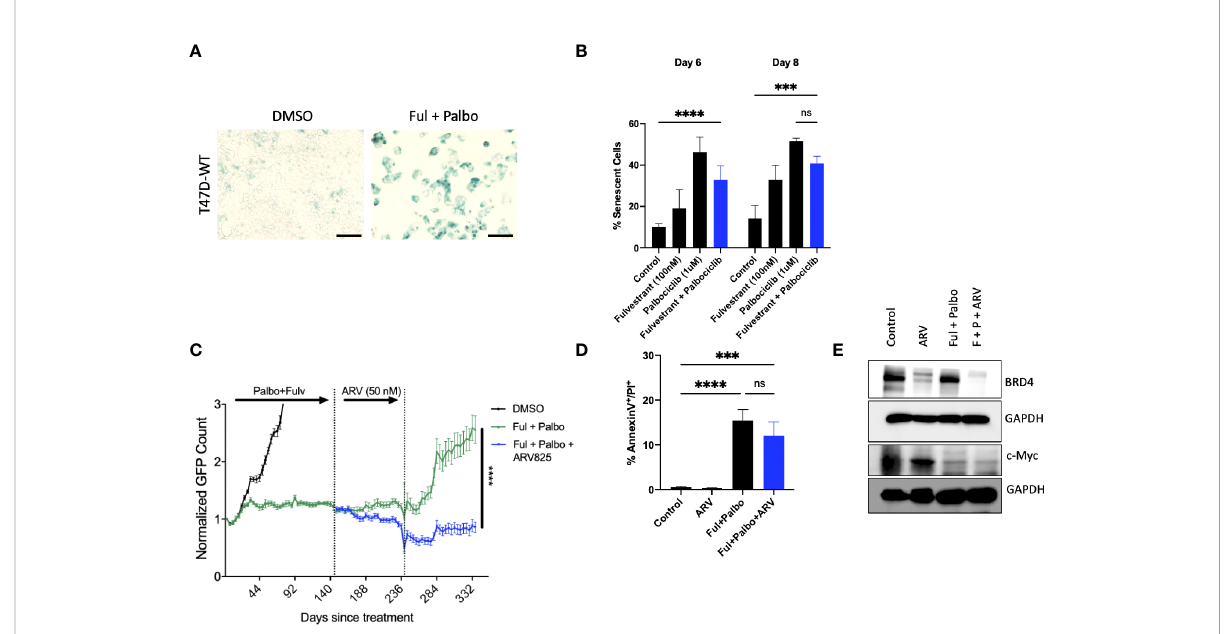
FIGURE 6 ARV prolongs growth arrest induced by Fulvestrant in combination with Palbociclib in p53 mutant T-47D cells. T47D-WT cells that were treated with palbociclib (1 µM) in combination with Fulvestrant (100 nM) for 6 days. (A) Cells were fi xed on Day 6, stained with x-gal staining solution, and imaged using bright fi eld microscope. All images were taken with the same magni fi cation. (B) Quanti fi cation of SA-Bgal using C12FDG at indicated timepoints. (C) Live cell viability was monitored via IncuCyte over a period of 14 days and normalized to GFP count. (D) Apoptosis was evaluated by fl ow cytometry using an APC Annexin V Apoptosis Detection Kit. (E) Western blotting for BRD4, c-Myc at day 4 of ARV treatment. Mean and SD were determined based on triplicates from 3 independent experiments. ***P ≤ 0.001, ****P ≤ 0.0001, ns (not signi fi cant) indicate statistical signi fi cance of each condition compared to control as determined using two ‐ way ANOVA with Sidak ’ s post hoc